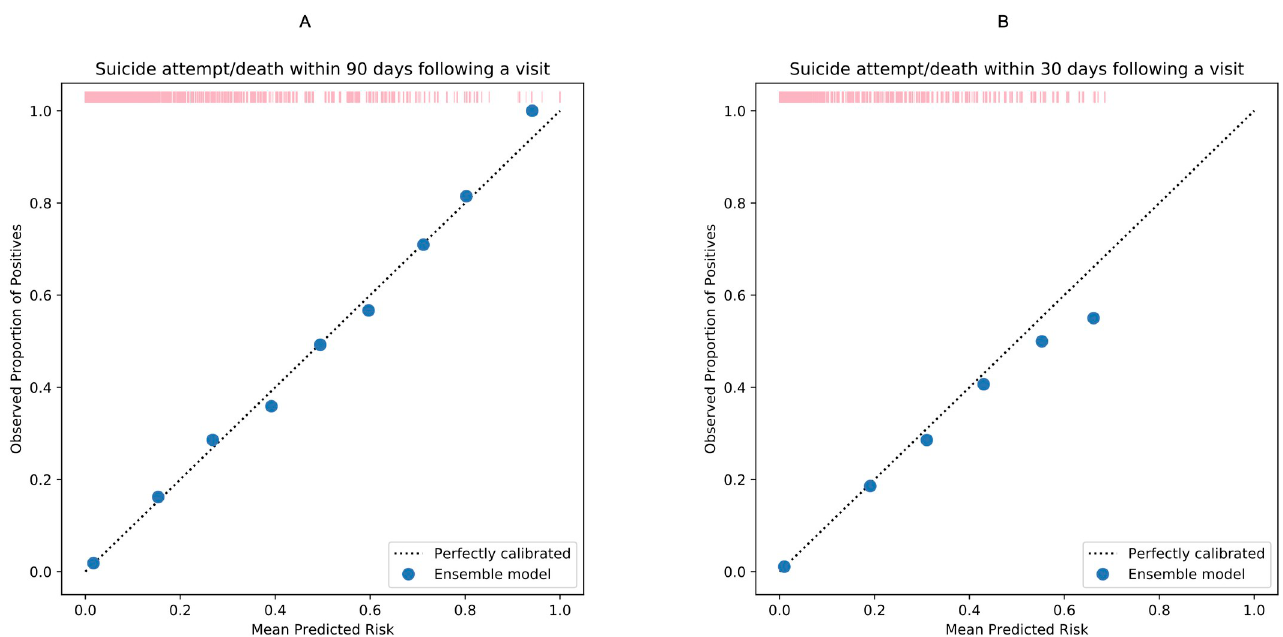
Fig 2. Calibration plots comparing observed proportion of positives and mean predicted risk suicide attempt/death within 90 (A) and 30 days (B) following a visit to psychiatric specialty care during 2011 and 2012. The figure was based on the calibration of the ensemble models. Each solid dot in blue represents the observed proportion of index visits followed by a suicidal event in a bin of sample (observed proportion of positives [suicidal events]) against the mean predicted risk in the same bin. More details can be found in S9 Table. The rug plot in pink represents the distribution of the study sample across different predicted risk levels.